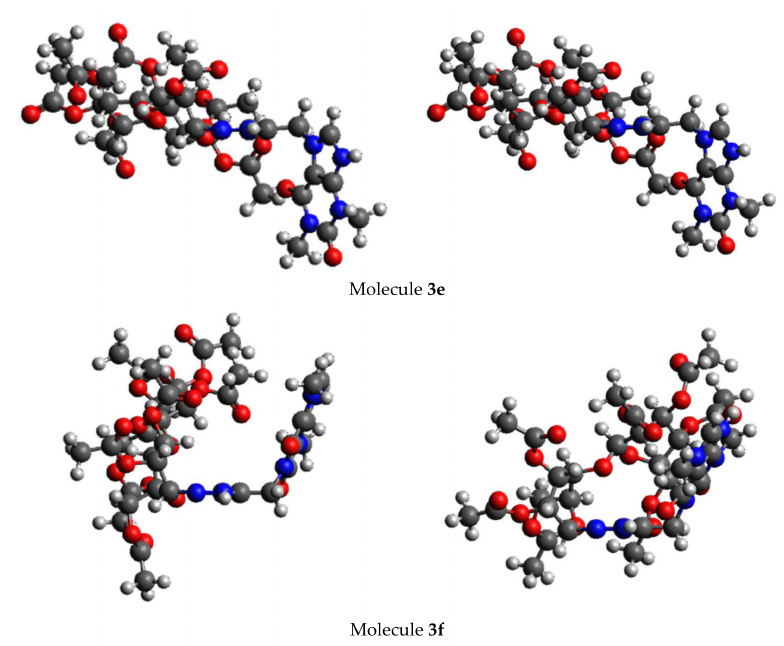
Figure 13. Optimized protonated inhibitor molecules without and with solvent effect.